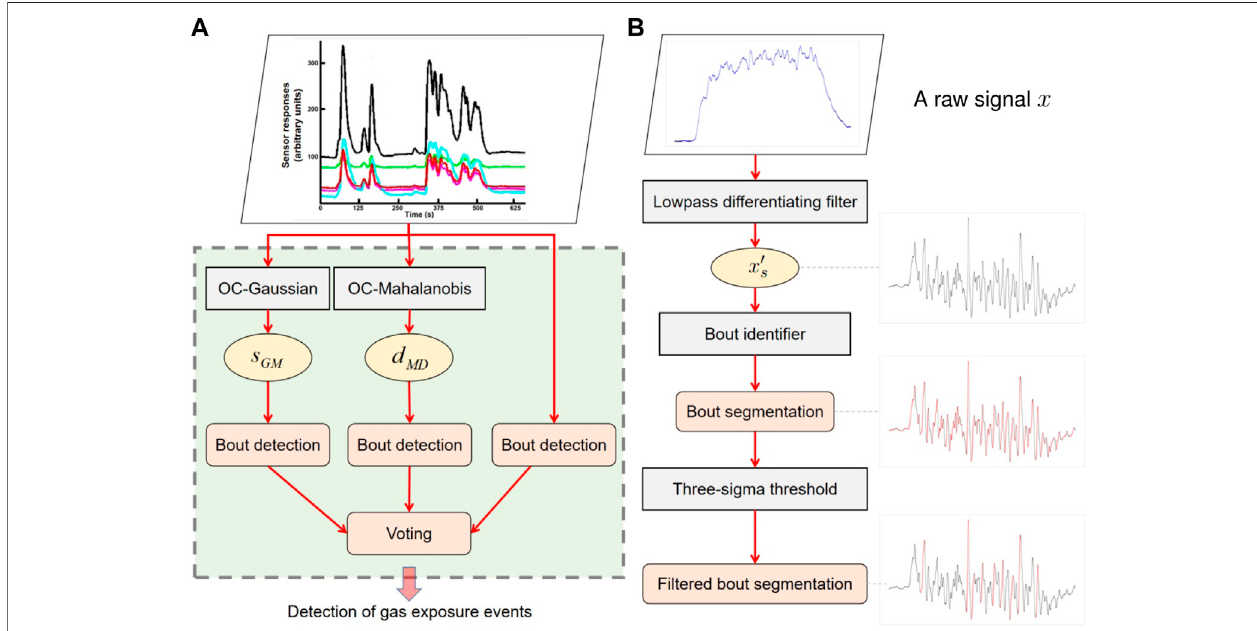
FIGURE 5 | Diagram of the Bout-Count Detection (BCD) model and the algorithm used for each base bout detection model. (A) Pipeline of the BCD model. (B) Diagram of the bout detection algorithm used in the BCD model. A raw signal will be fi ltered to remove high-frequency noise fi rst. From the fi ltered signal x s ,